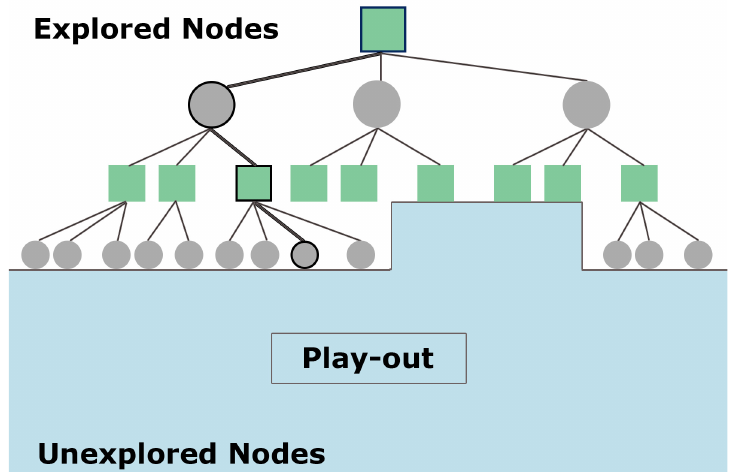
Figure 1. Explored and unexplored nodes in a MIN/SUM game tree framework. Green squares signify MIN nodes and gray circles signify SUM nodes. Nodes with black outline signify the most proving node.